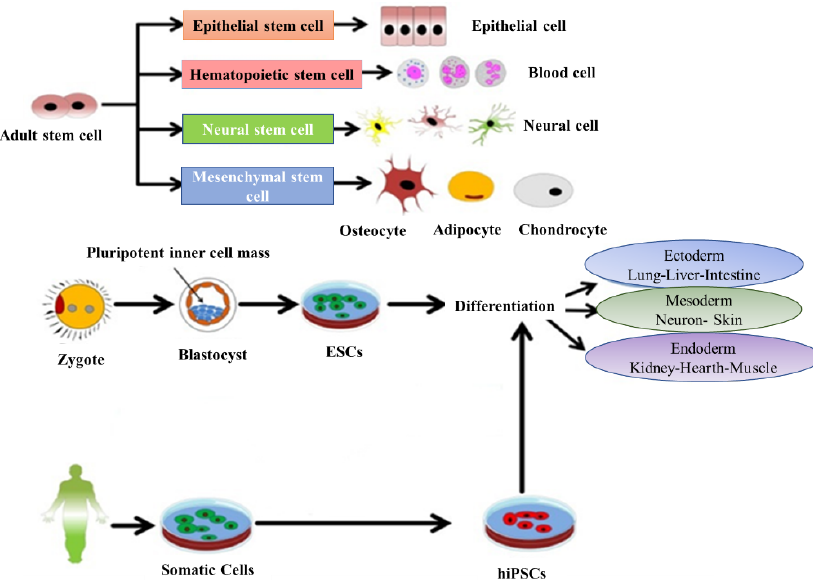
Figure 1. Representative diagram depicting the main types and sources of stem cells and their potential to differentiate into various lineages. Adapted with permission from [22] , Abdal Dayem et al.,